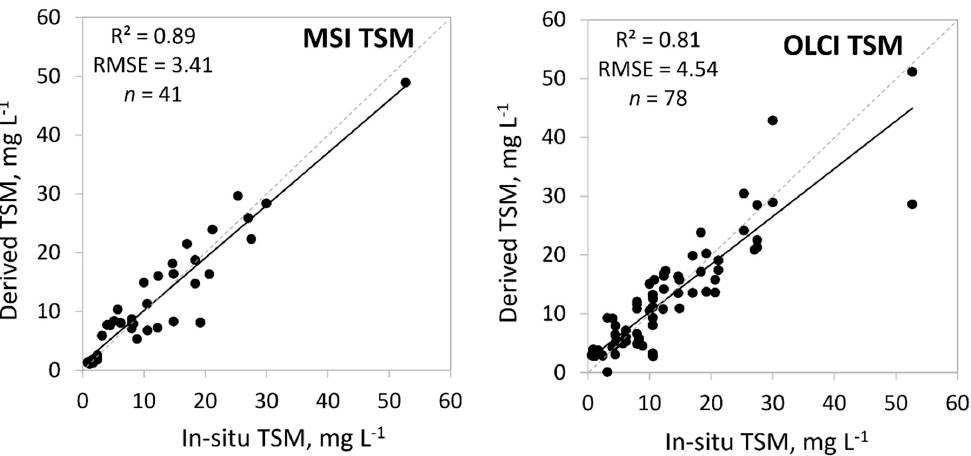
Figure 7. Correlation between in-situ and satellite derived total suspended matter (TSM, mg L -1 ) based on the optical water types (OWTs). Also, R 2 , RMSE, and the number of samples ( n ) are given. Table 4. The best MSI and OLCI band ratios and their R 2 and RMSE for total suspended matter (TSM) based on the optical water types (OWTs).